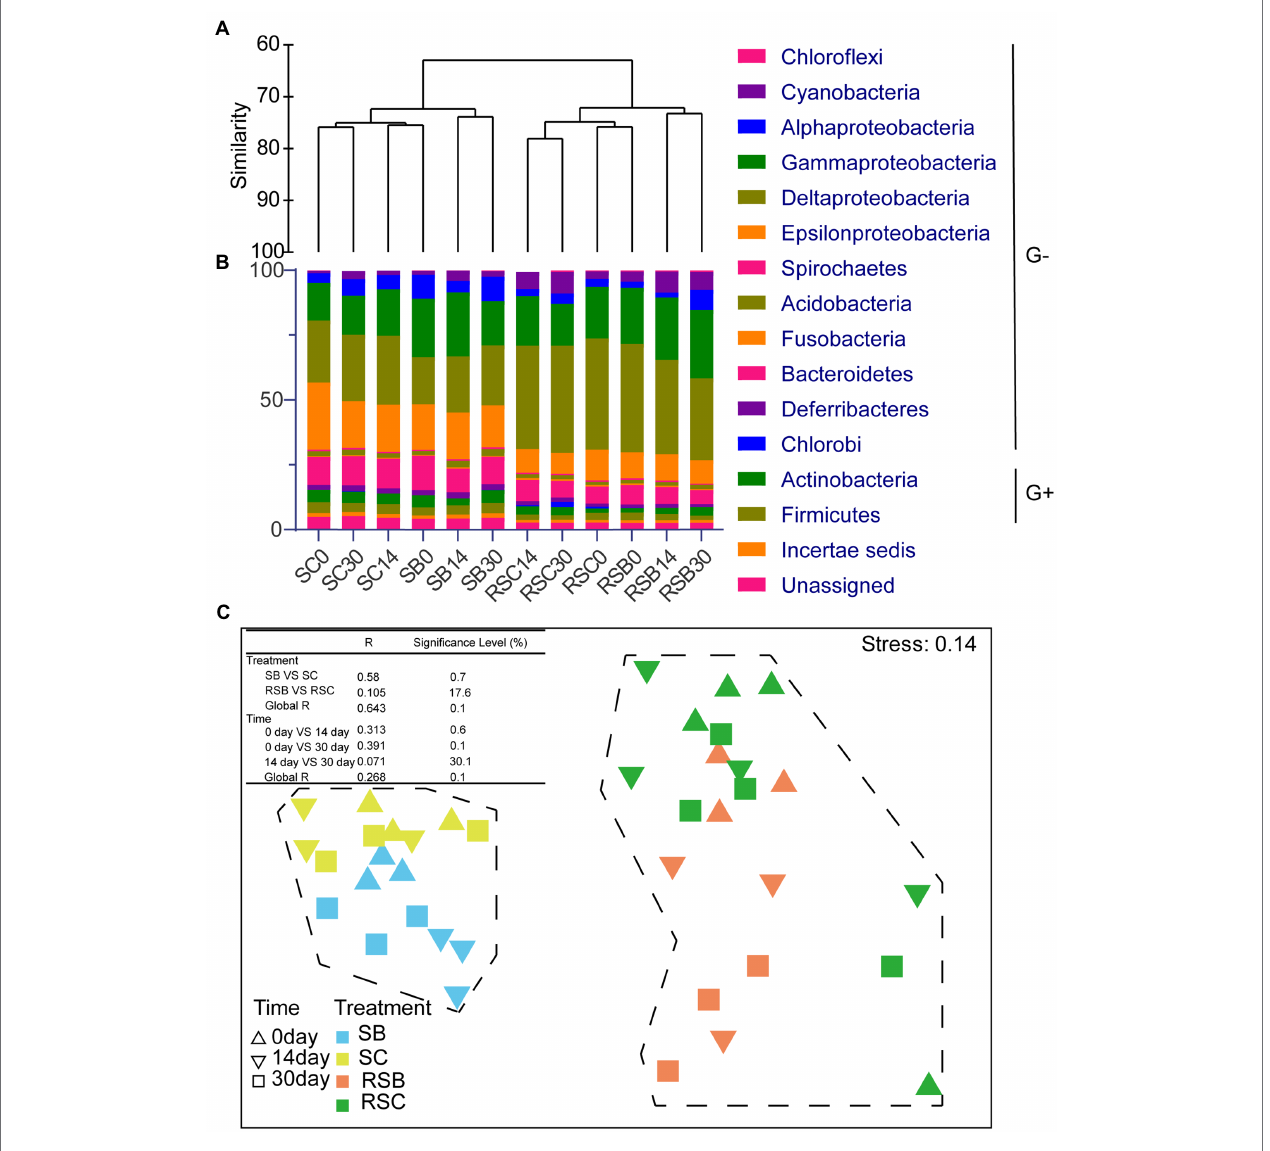
FIGURE 1 | (A) Dendrogram cluster for 12 combined samples based on Bray-Curtis similarity. (B) Histogram showing the relative abundance of different subgroups (Phylum and Class level), G+ means Gram-positive bacteria while G − means Gram-negative bacteria. (C) Non-metric multidimensional scaling ordinations (nMDS) for bacteria communities of 39 samples. [Table in the figure were analysis of similarities (ANOSIM) of bacterial communities. SB, Sediment bacteria of treatment groups; SC, sediment bacteria of control groups; RSB, rhizosphere bacteria of treatment groups; RSC, rhizosphere bacteria of control